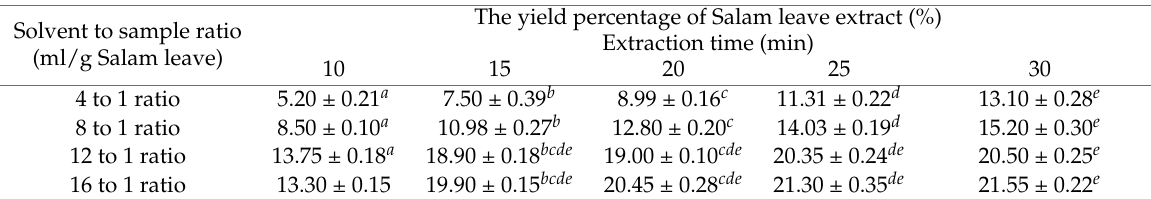
Table 1. The yield percentage of Salam leave extract The yield percentage of Salam leave extract (%) Solvent to sample ratio